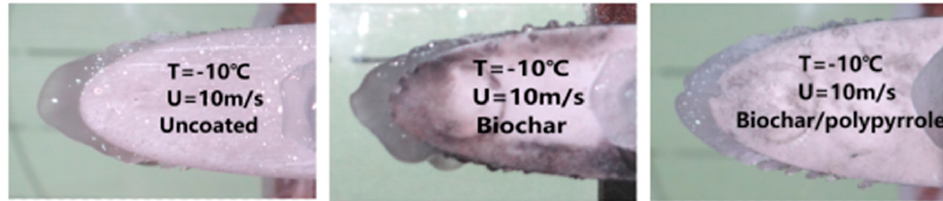
Figure 7. Photos of blade icing of uncoated coating, biochar coating, and biochar/polypyrrole coating at − 10 °C and 10 m/s.